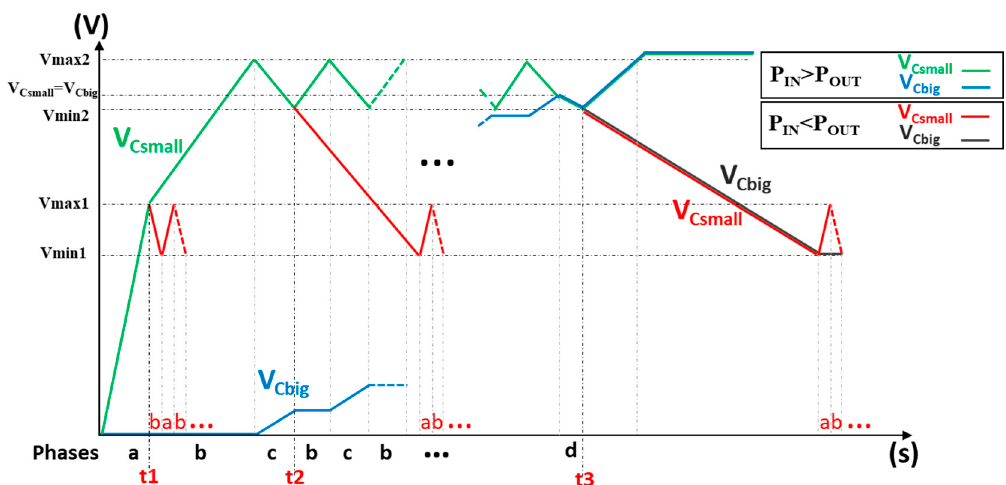
Figure 5. Operation principle of the proposed variable storage architecture for two scenario cases: harvested power (P IN ) ≥ consumed power (P OUT ) and harvested power (P IN ) < consumed power (P OUT ) (red curves, times t1, t2 and t3).